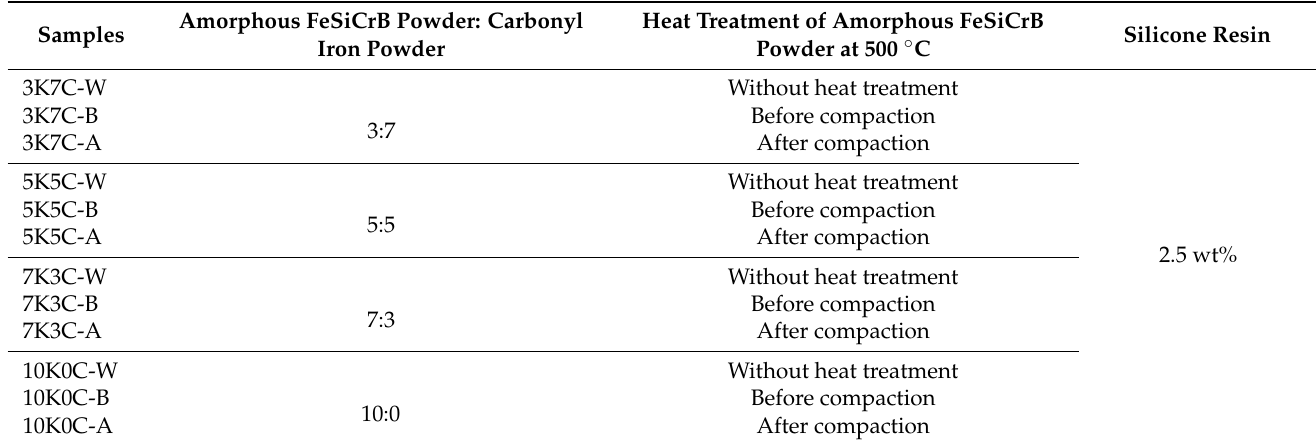
Table 1. Chemical compositions and heat-treatment procedures of the samples.